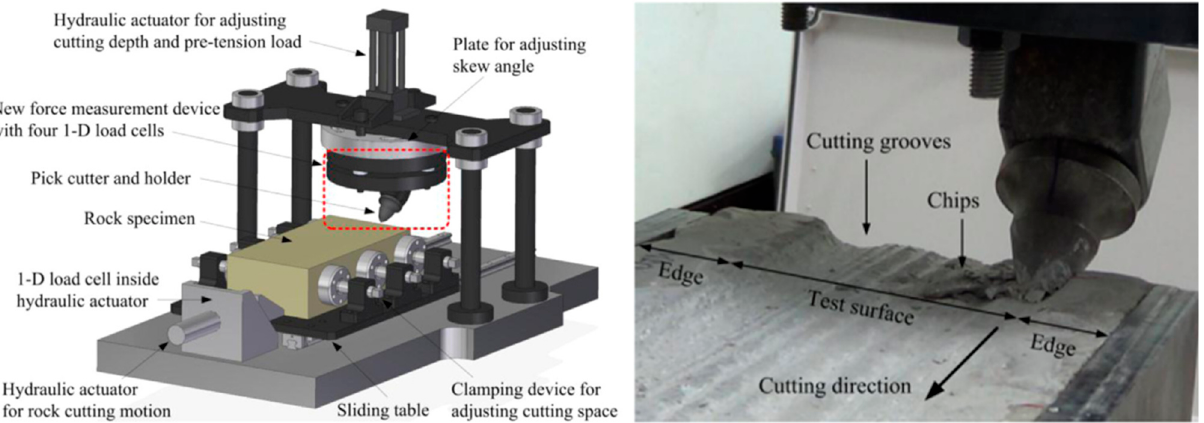
Figure 9. Compact LCM bench for testing picks [41].